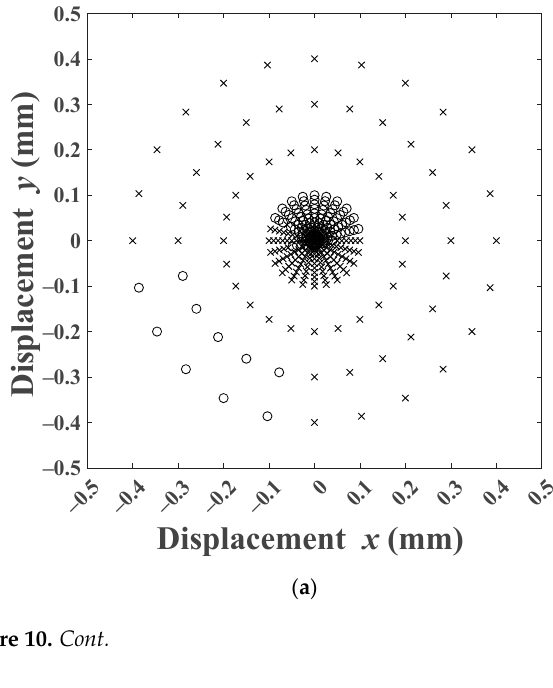
Figure 9. Initial conditions for which the rotor response converges: ρ = 0.08 mm and ω = 100 rad/s: ( a ) PD controller, ( b ) FLC, ( c ) FBBRC (note: ‘o’ for successful and ‘×’ for failed responses).